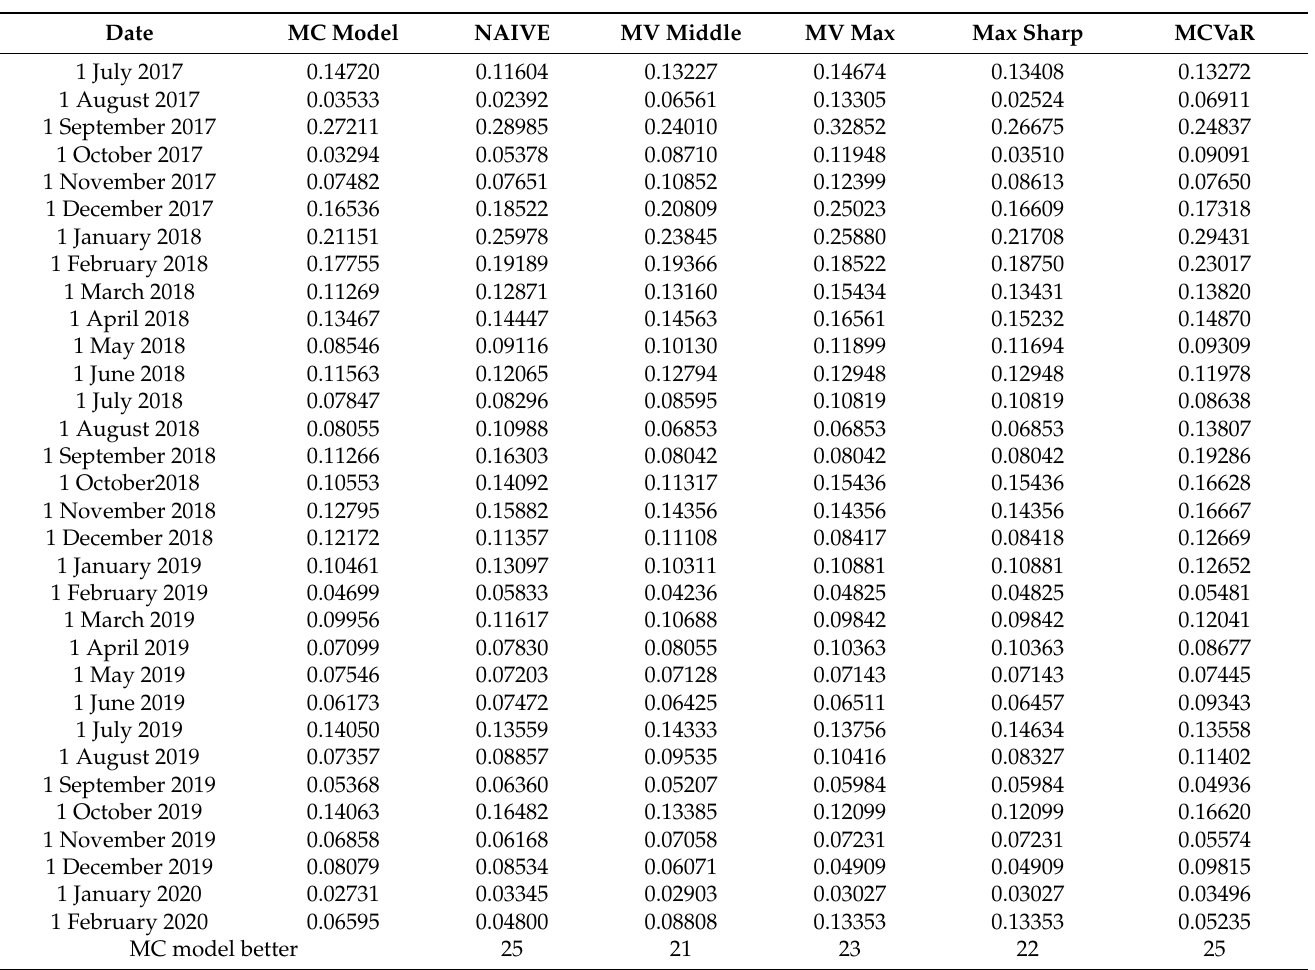
Table A3. VaR of the returns in the next 30